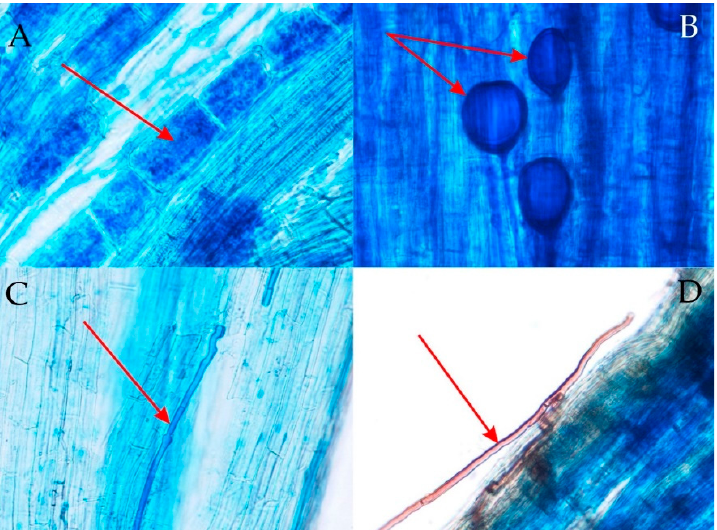
Figure 1. Fragments of the root system of Filipendula vulgaris Moench. Arbuscules inside cortical cells ( A ) and vesicles formed by arbuscular mycorrhizal fungi (AMF) ( B ); mycelia of dark septate endophytes (DSE) ( C , D ) (photo: M. Fecowicz).